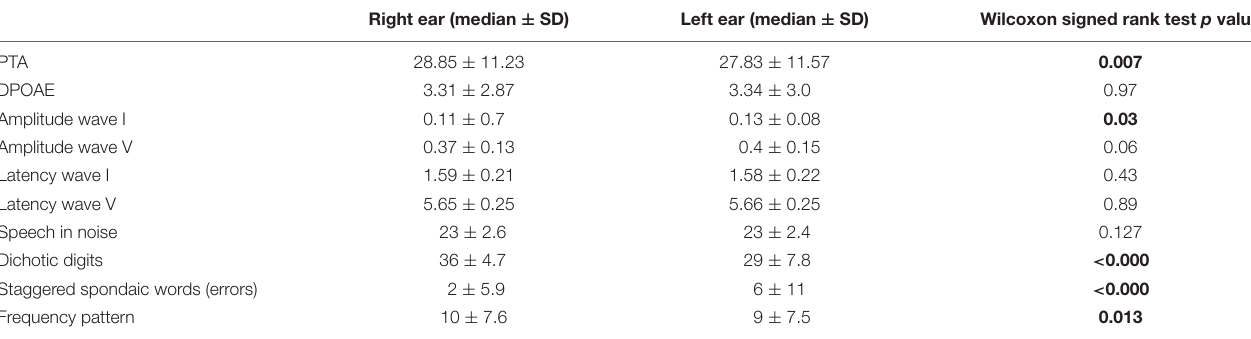
TABLE 2 | Performance of both ears in tests of hearing and auditory